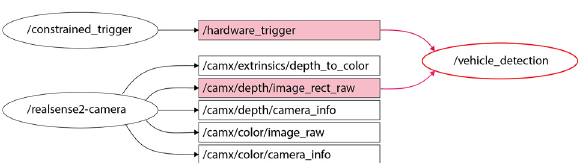
Figure 4 . ROS computation graph of the developed edge-based software framework. Nodes are represented as ellipses and data topics as